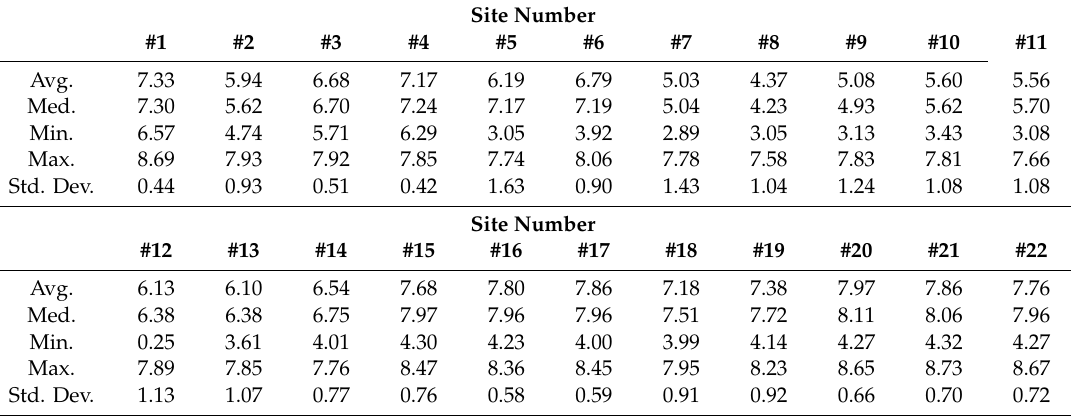
Table A3. Descriptive statistics of pH at each sampling location (n = 22) during study period (2 January 2018–1 January 2019) in West Run Watershed, WV, USA. Avg. = average, Med = median, Min. = minimum, Max. = maximum and Std. Dev. = standard